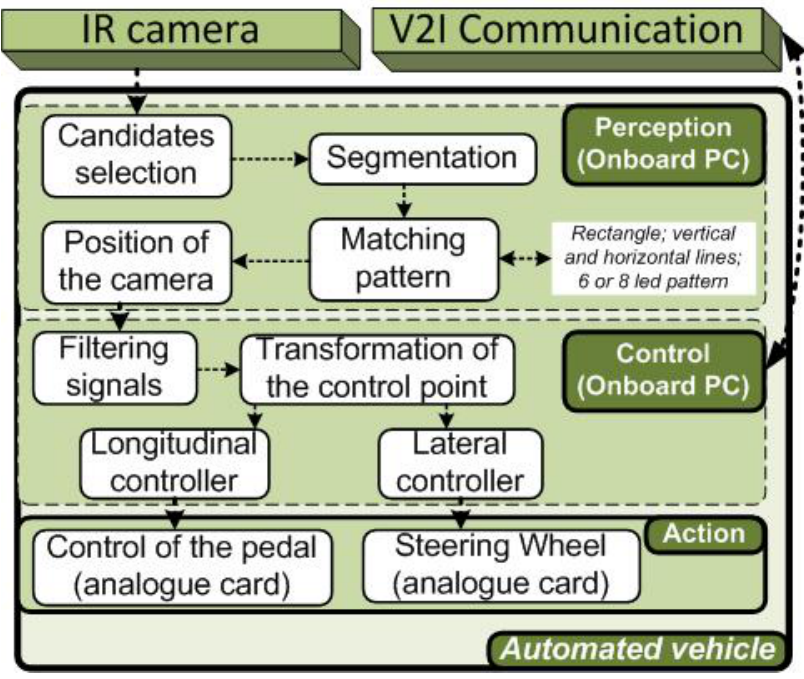
Figure 4. Control architecture for autonomous vehicles based on IR camera